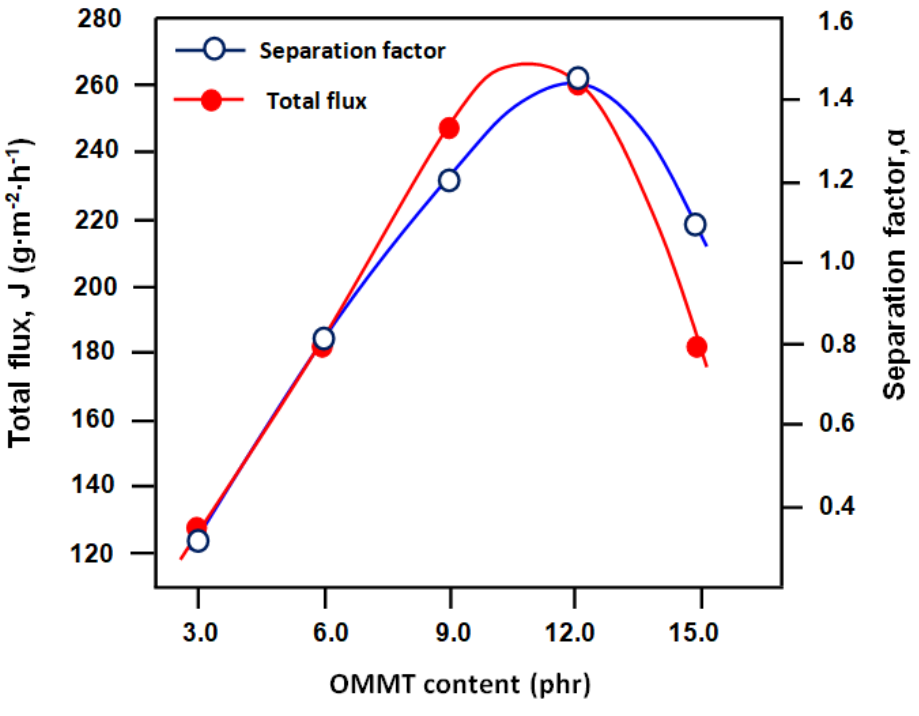
Figure 11. Variation in the trans-membranar flux and the separation factor versus the concentration of OMMT for the separation of the toluene – methanol azeotropic mixture.